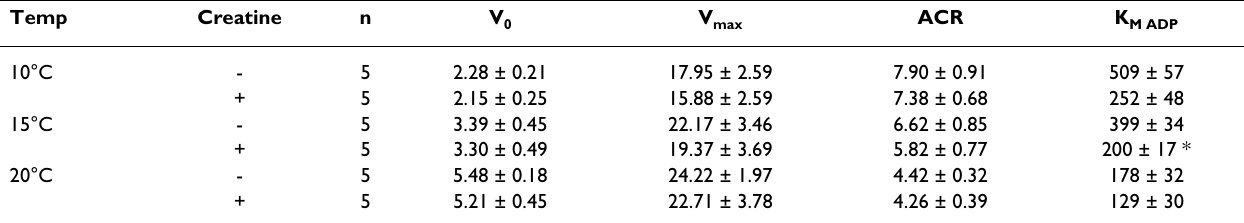
Table 1: ADP-kinetics of respiration in permeabilized fibres in mammalian R-solution